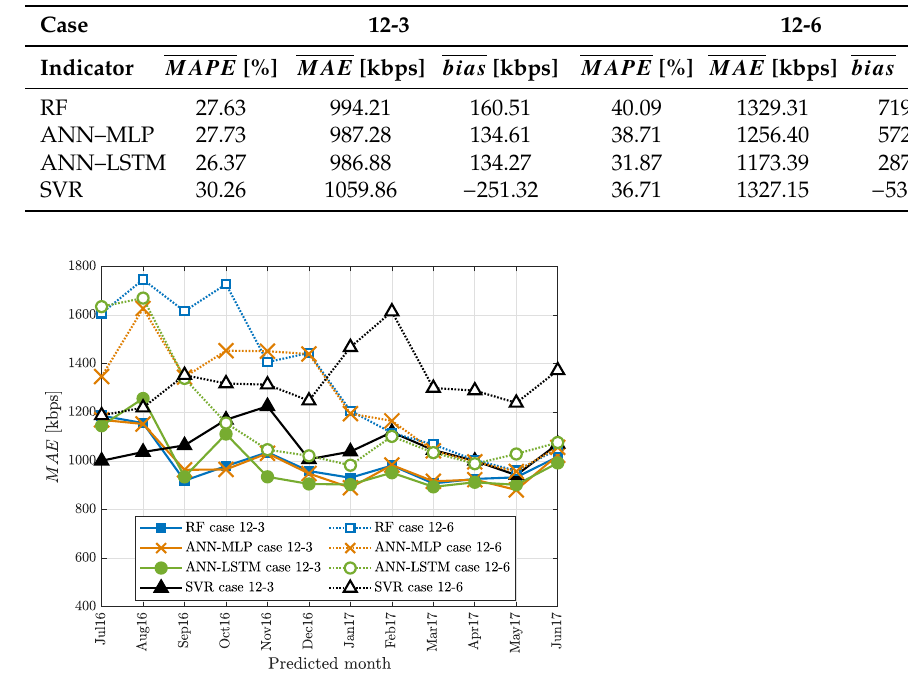
Table 4. Summary of method and time horizon comparison across months.